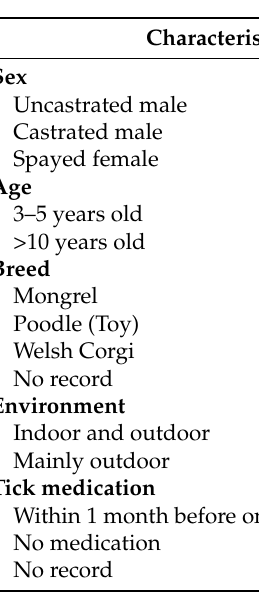
Table 1. Information on the dogs with SFTS ( n = 7).